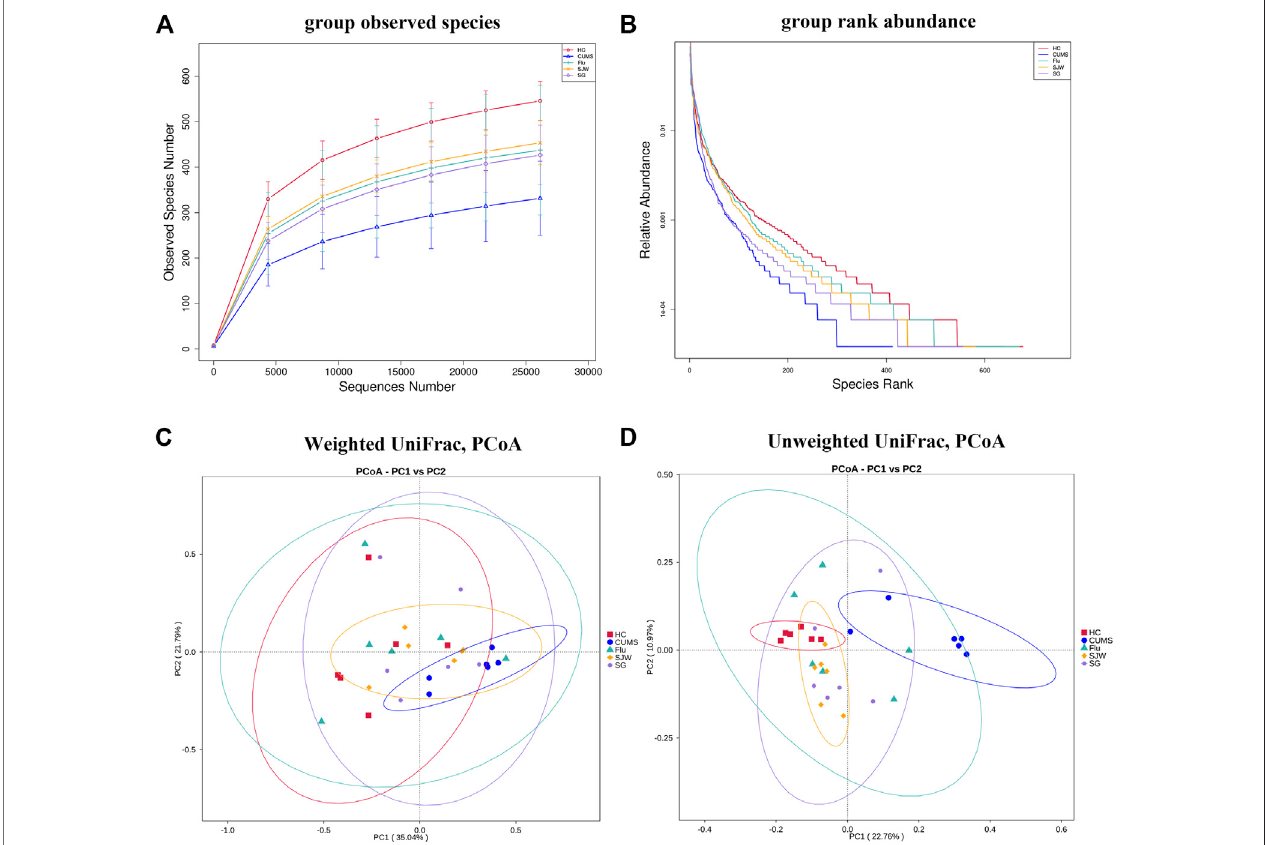
FIGURE6|(A) Rarefactioncurve.Theabscissaisthenumberofsamplingsequencesandtheordinateisthenumberofobservedspecies.Whenthecurvetendsto be fl at,itindicatesthattheamountofsequencingdataisgraduallyreasonable,andindirectlyre fl ectstheabundanceofspeciesinthesample. (B) Grouprankabundance curve. In the horizontal direction, the larger the curve width is, the higher the species abundance is; in the vertical direction, the smoother the curve is, the more even the speciesdistribution is. (C) PCoAplotsofbacterialbeta-diversity onthebasisofWeightedUniFracdistances. (D) PCoAplotsofbacterialbeta-diversityonthebasis of Unweighted UniFrac